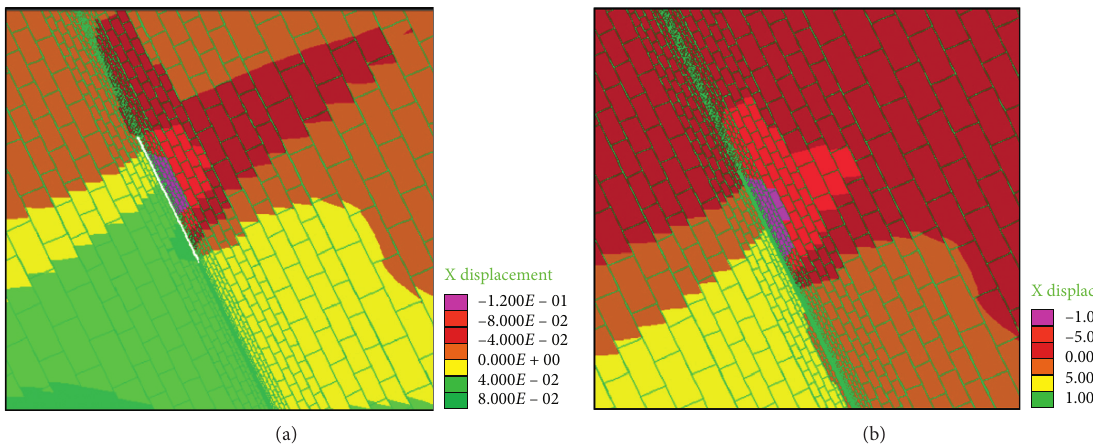
Figure 4: Horizontal displacement contours of surrounding rock with 80m stope height. (a) Caving. (b)